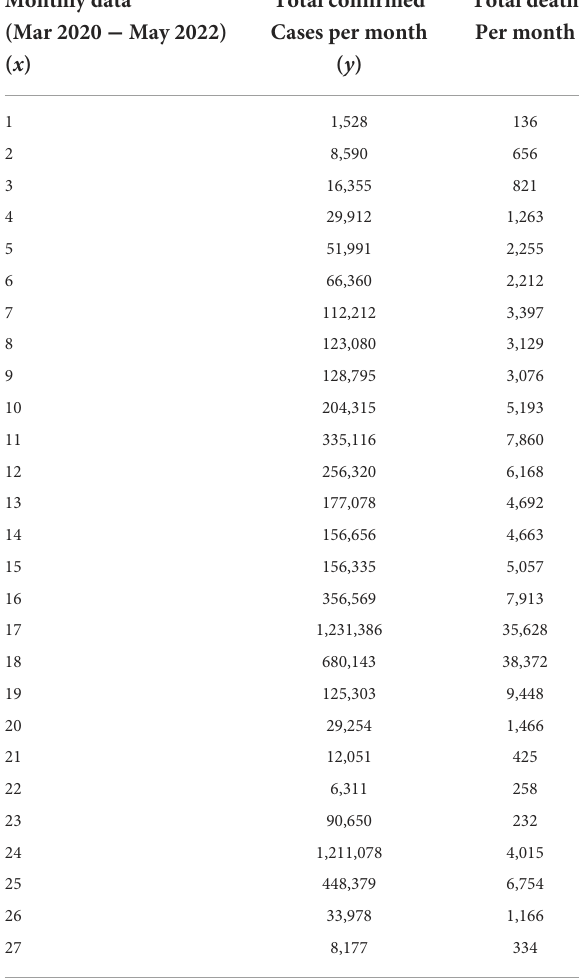
TABLE 4 Performance results of FMSD method for optimization of the quadratic model Equation (25). Initial